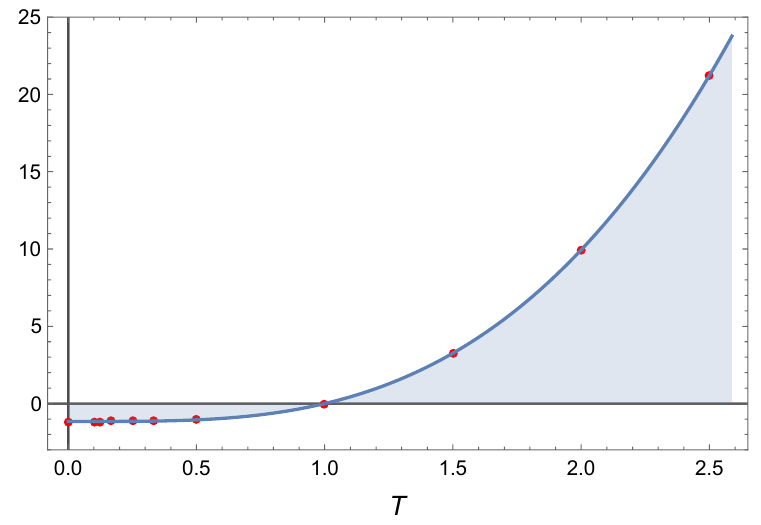
Figure 1 . Energy density of a scalar (cid:12)eld conformally coupled to R (cid:2) H d (cid:0) 1 for d = 3 and (cid:11) = 1 found from numerical integration of eq. (2.17), as a function of T = 2 (cid:25)(cid:11)=(cid:12) . The red points correspond to rational values of T where the integral can be solved